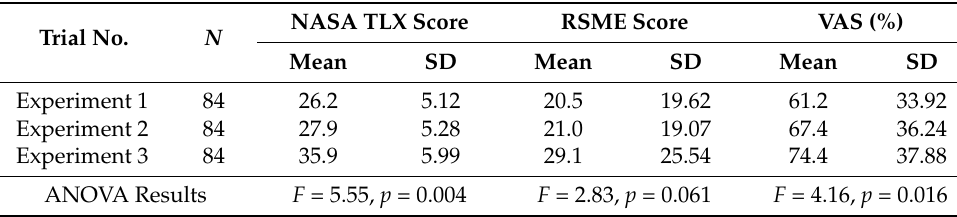
Table 5. Analysis of variance (ANOVA) results for workload, fatigue, and effort. Trial No.